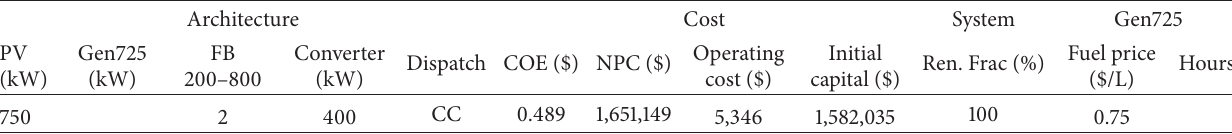
Table 5: HOMER simulation result showing optimization case with categorized option.